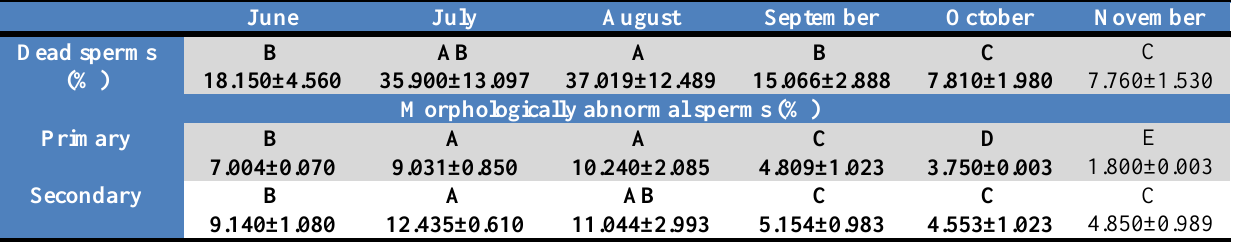
Table (3): Effects of heat stress on the percentages of dead and abnormal sperms during study months